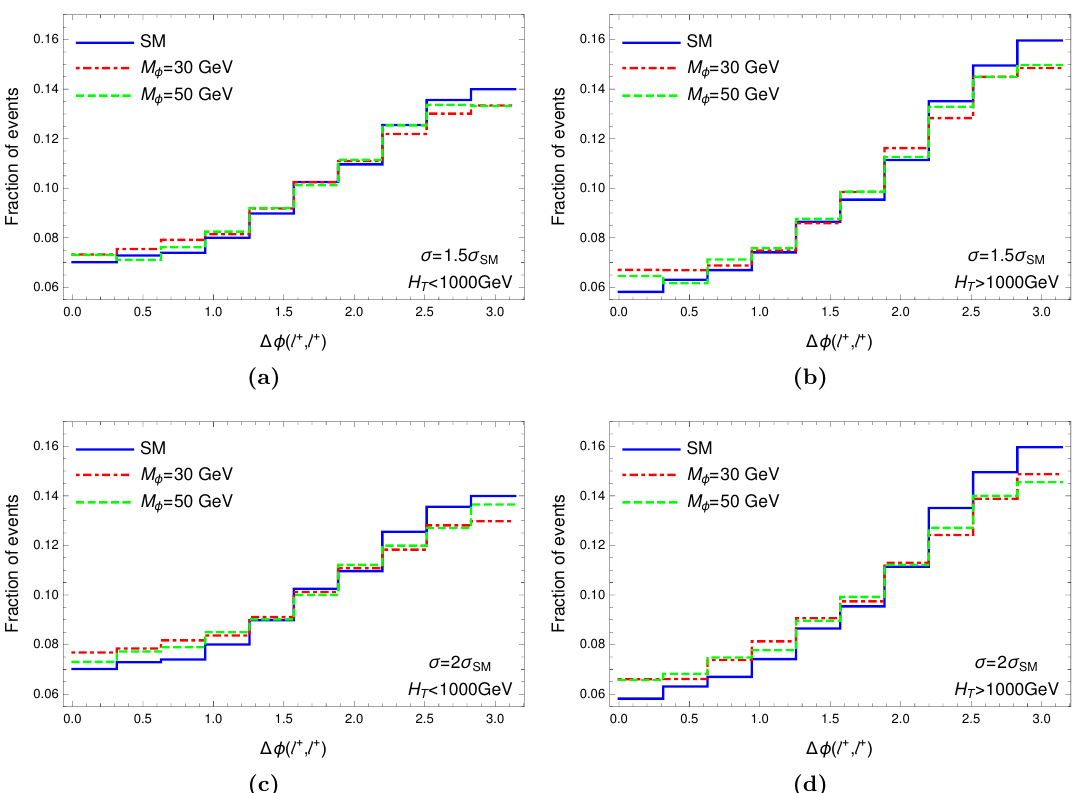
Figure 11. Distribution of the azimuthal separation between the same-sign leptons, (cid:1) (cid:30) ( ‘ + ; ‘ + ), for the 2LSS channel after preselection (see text for details) with (left) H T < 1000 GeV and (right) H T > 1000 GeV, normalized to unit area. Shown are the predictions for the SM (blue) and the Scalar model for (a, b) the tight benchmark points (i.e. giving (cid:27) = 1 : 5 (cid:27) SM ) and (c, d) the loose benchmark points (i.e. giving (cid:27) = 2 (cid:27) SM ).